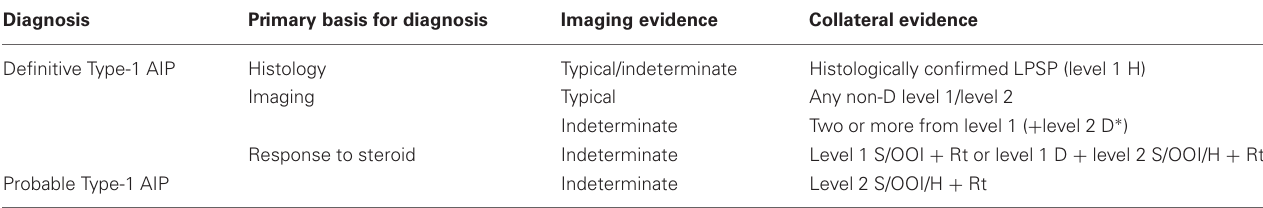
Table 2 | Diagnosis of definitive and probable Type-1 AIP using international consensus diagnostic criteria.